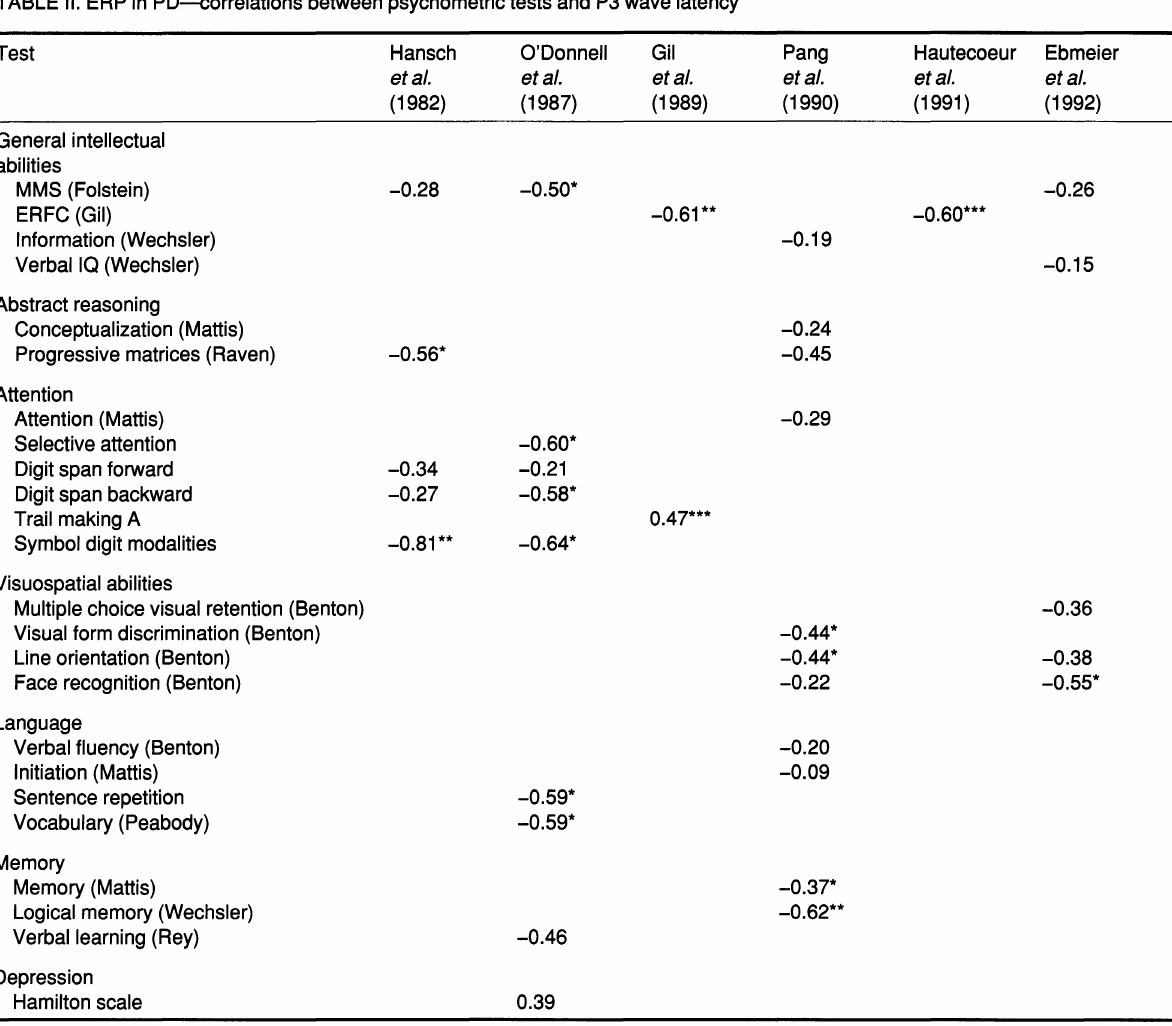
TABLE II. ERP in PD-correlations between psychometric tests and P3 wave